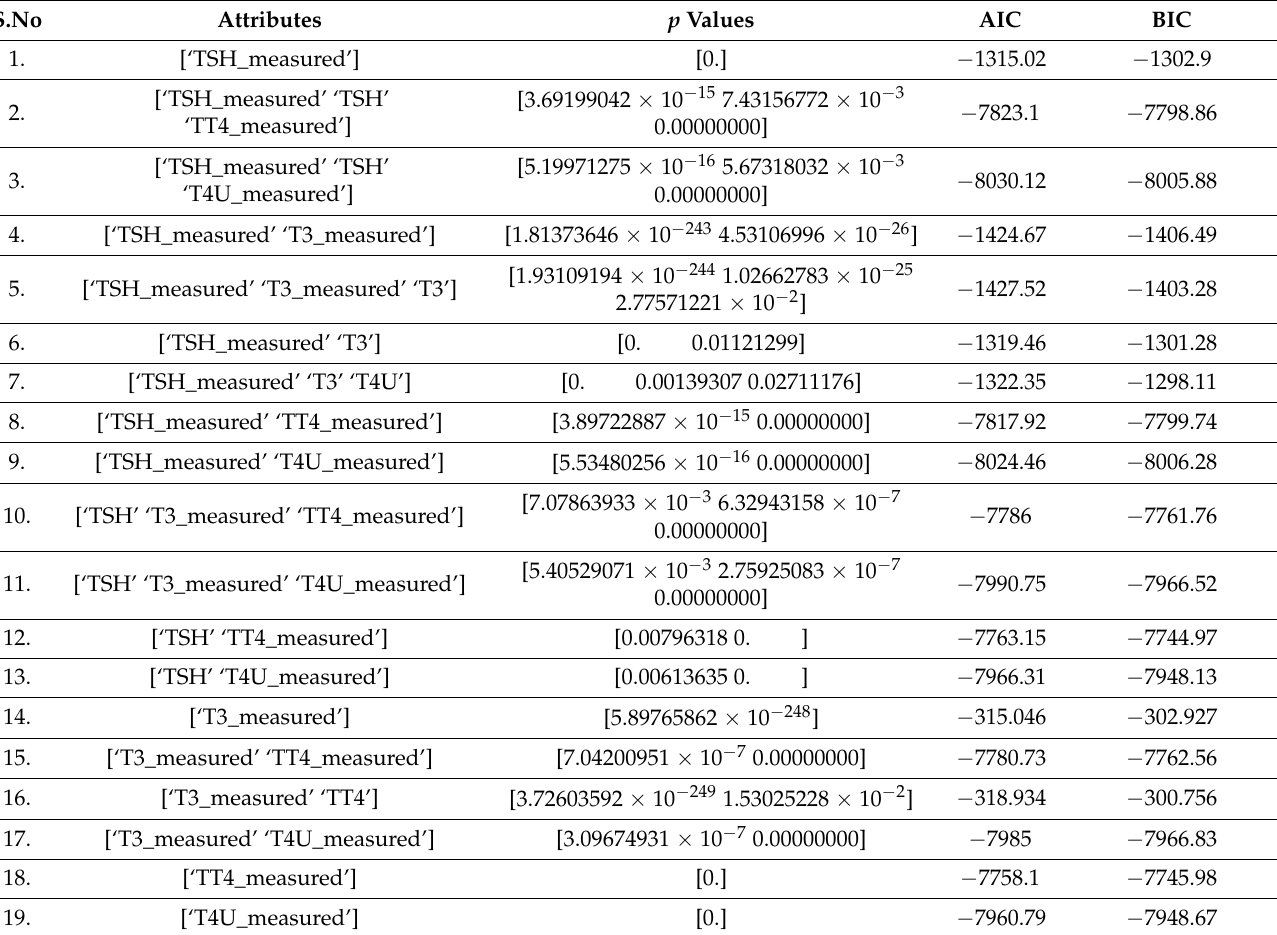
Table 26. OLS features of the significant subset attributes of the hypothyroid dataset.